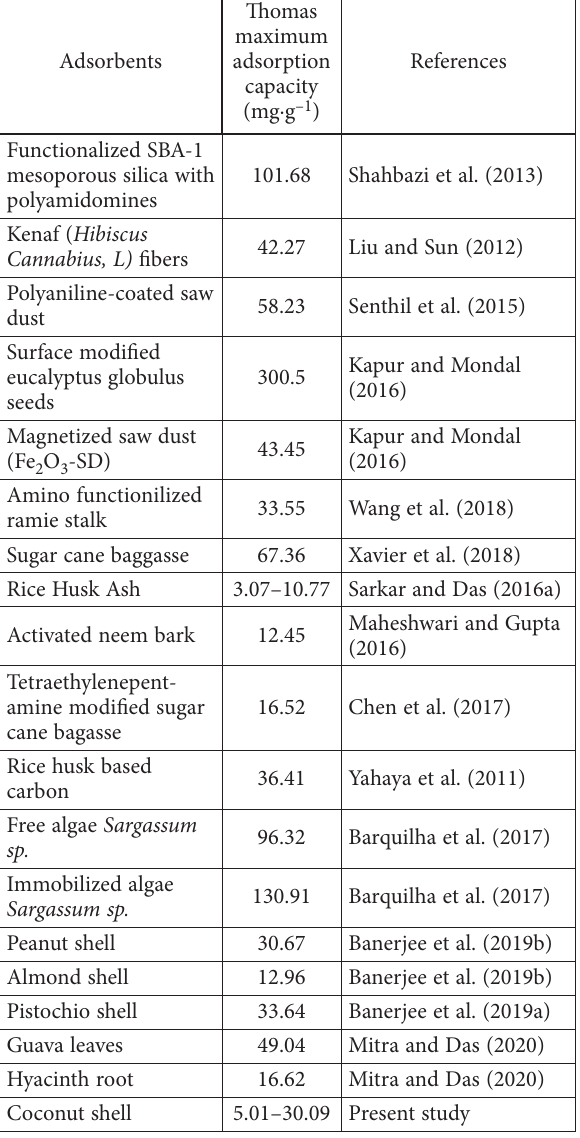
Table 9. Different capacities of Cu(II) removal by several adsorbents previously reported by other researchers